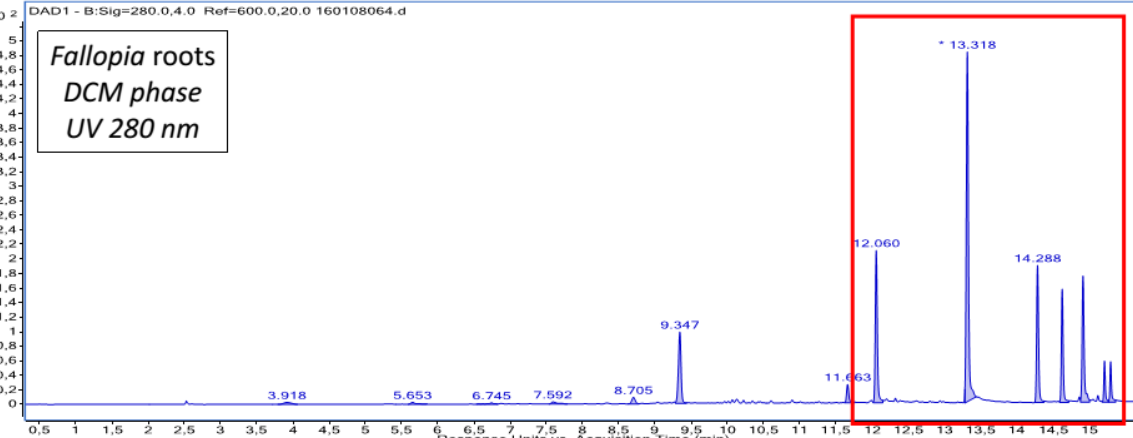
Figure A7. UHPLC chromatogram with UV detector at 280 nm of F. japonica roots DCM fraction.